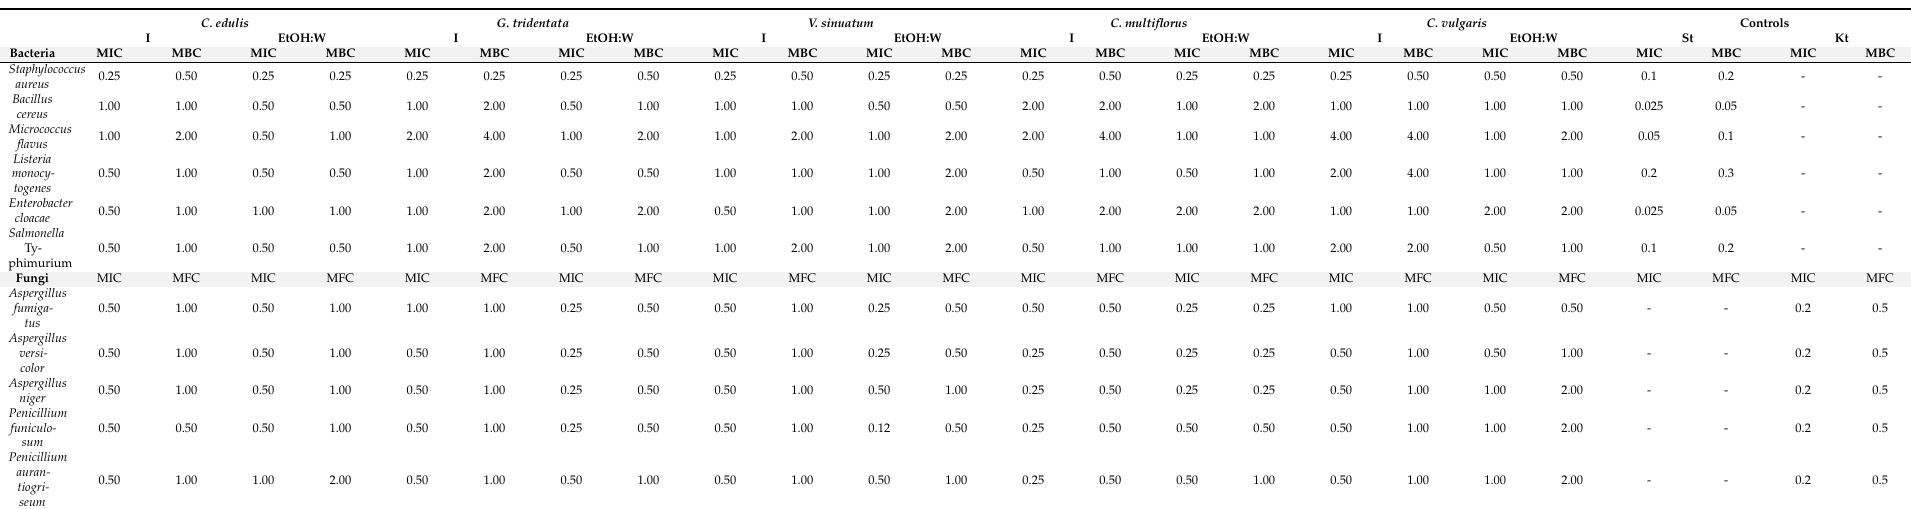
Table 3. Antimicrobial activity of infusions and hydroethanolic extracts of selected plants